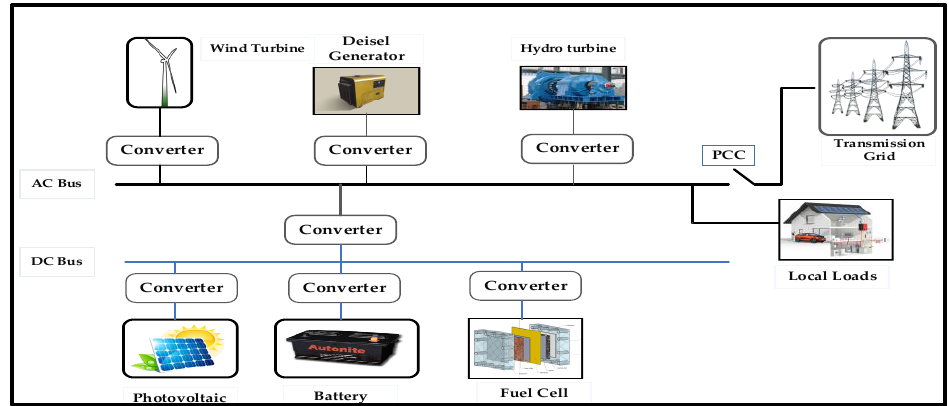
Figure 1. A microgrid energy management system.